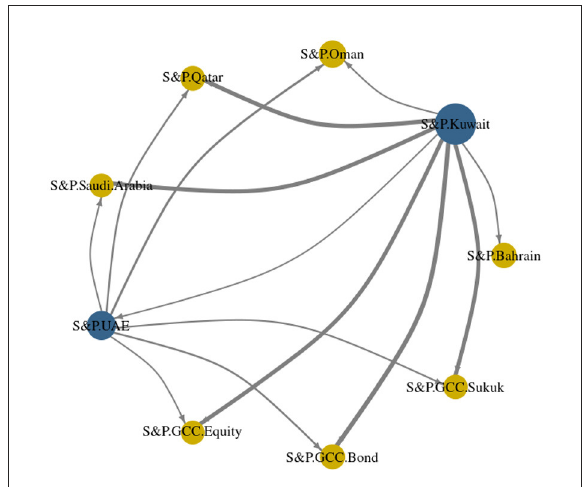
FIGURE7 Dynamic connectedness network plot by DCC. The of TVP-VAR approach network plot is displayed in the Figure 6. The Blue nodes exhibit the net transmitter role of bond and equity market indices and yellow nodes illustrate the net receiver of the shocks. Vertices are the measures of weighted average net pairwise directional connectedness. The nodes size shows the weighted average net total directional